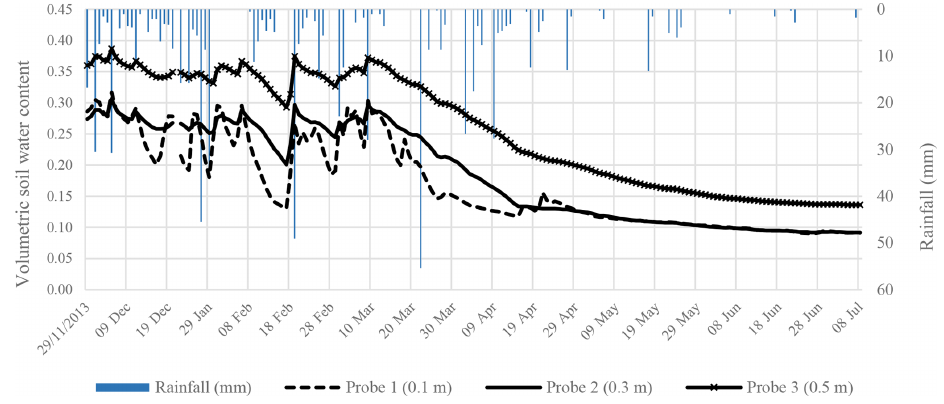
Figure 8. Hourly volumetric soil water content and the hourly rainfall at site 1 at New